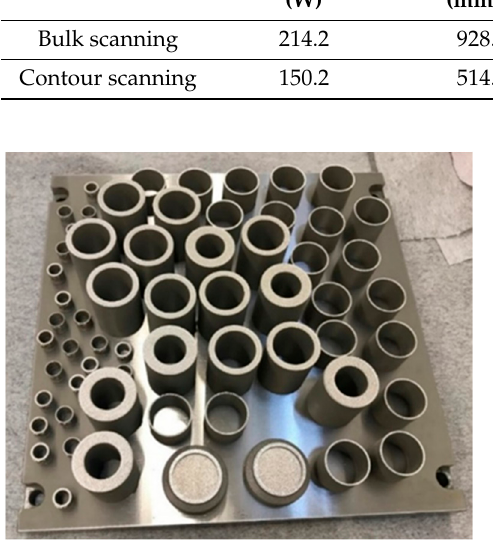
Figure 1. EOS M290 build plate with the cylindrical samples after printing.